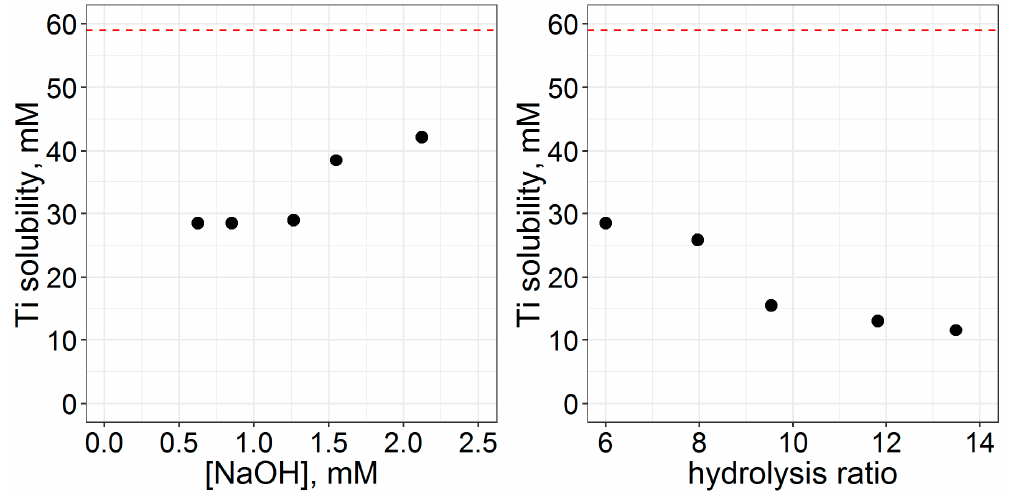
Figure 4. The concentration of Ti in mother liquors after two hours of the synthesis according to ICP-MS data; the dashed line denotes Ti(O n Bu) 4 concentration in the beginning of the synthesis.